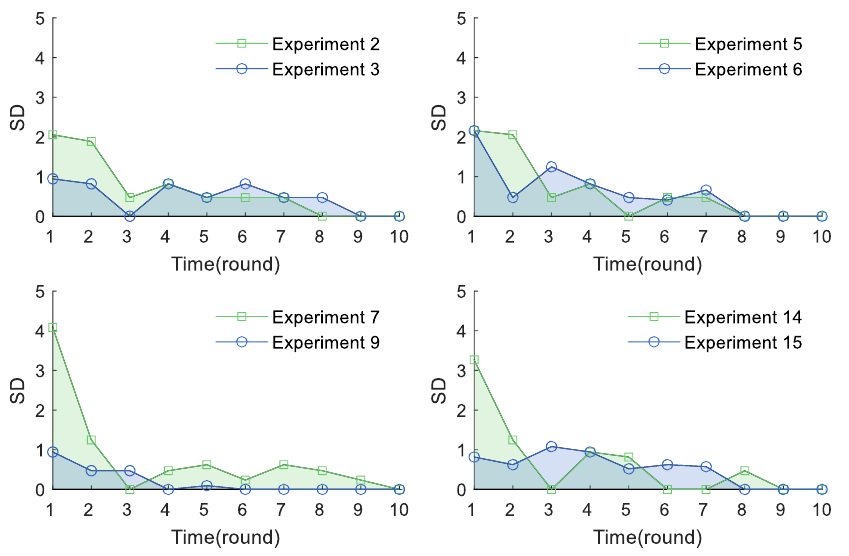
Figure 8. The impact of rewards and punishments on free riding.